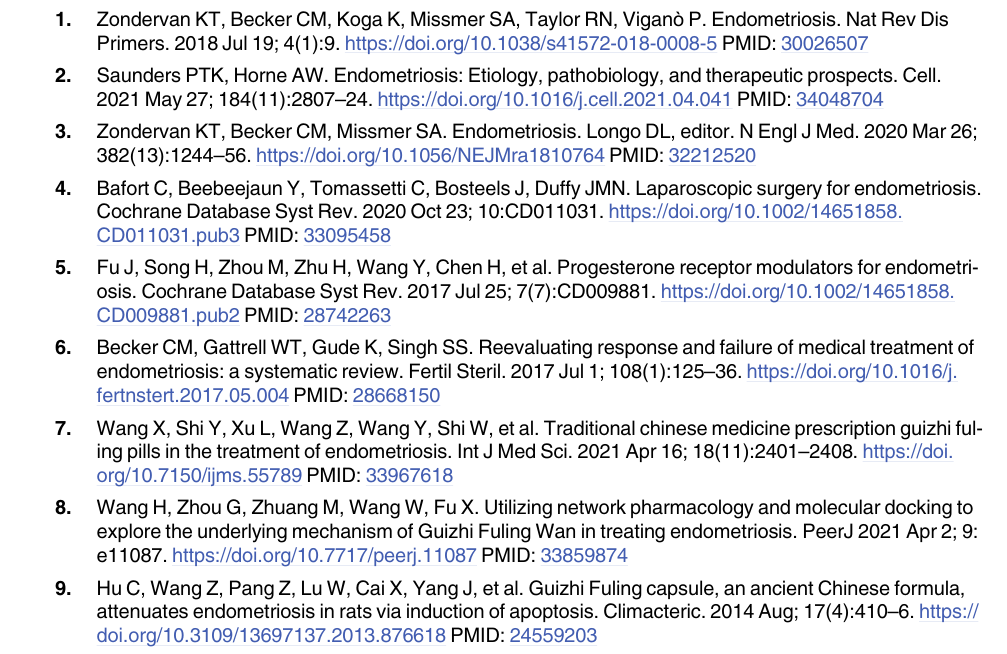
S1 Table. Information for 49 active